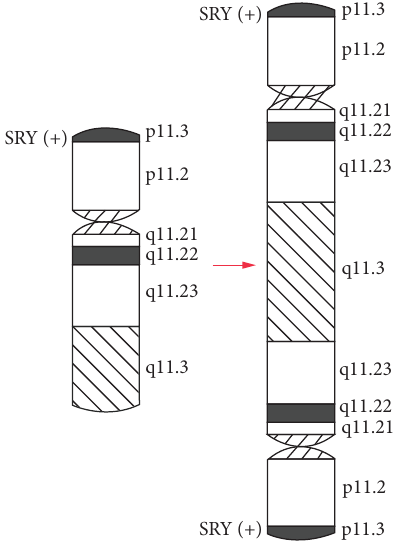
Figure 3: A diagram of the psu idic